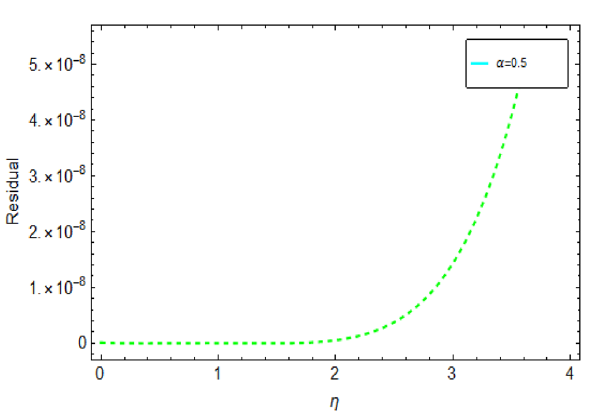
Figure 1. 3D plots found by the suggested technique for FZK(3,3,3) at y = 0.1 and α = 1 .